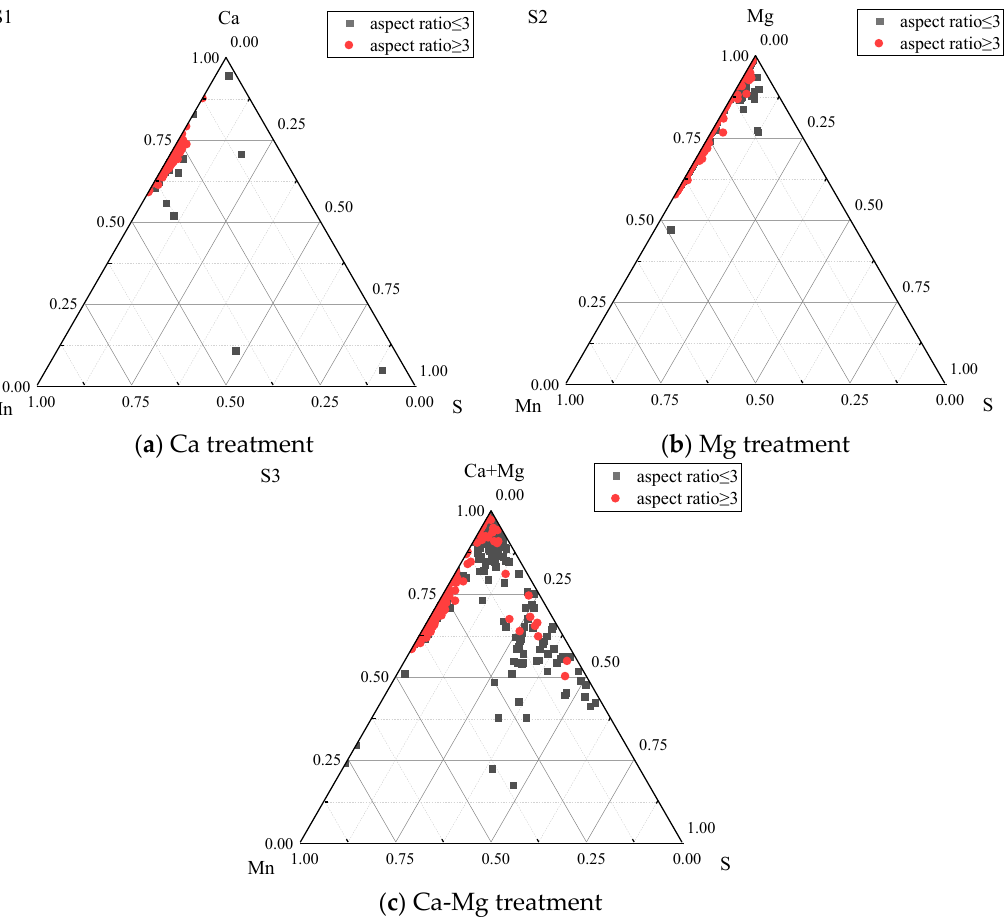
Figure 11. Relationship between content of Ca and Mg and aspect ratio in MnS.